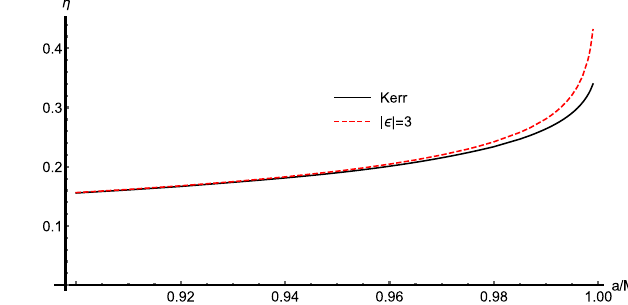
radiative efficiency η for Kerr (black) and Kerr-like black holes (red dashed), as a function of the black hole spin. The further enhancement of η for Kerr-like black holes at large spins is clearly